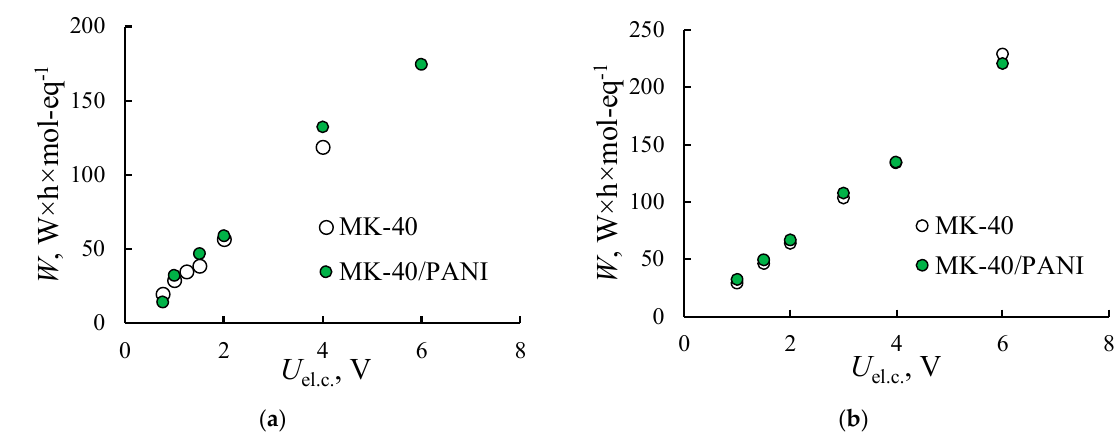
Figure 9. Energy consumption for the electrodialysis treatment of NaCl + CaCl 2 ( a ) and HCl + CaCl 2 ( b ) solutions with the initial MK-40 and composite MK-40/PANI membranes.